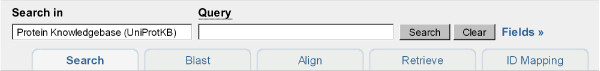
Basic search form.